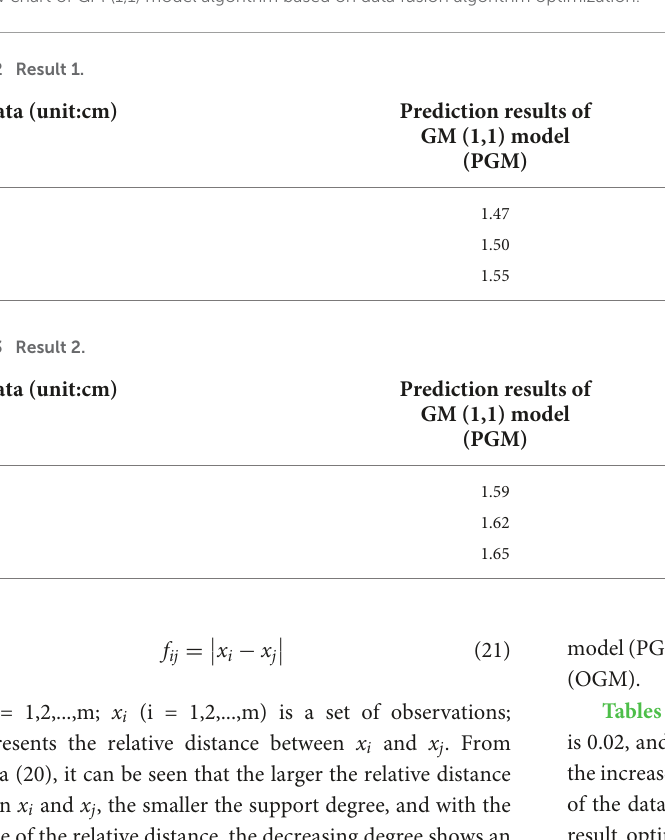
FIGURE7 Flow chart of GM (1,1) model algorithm based on data fusion algorithm optimization.